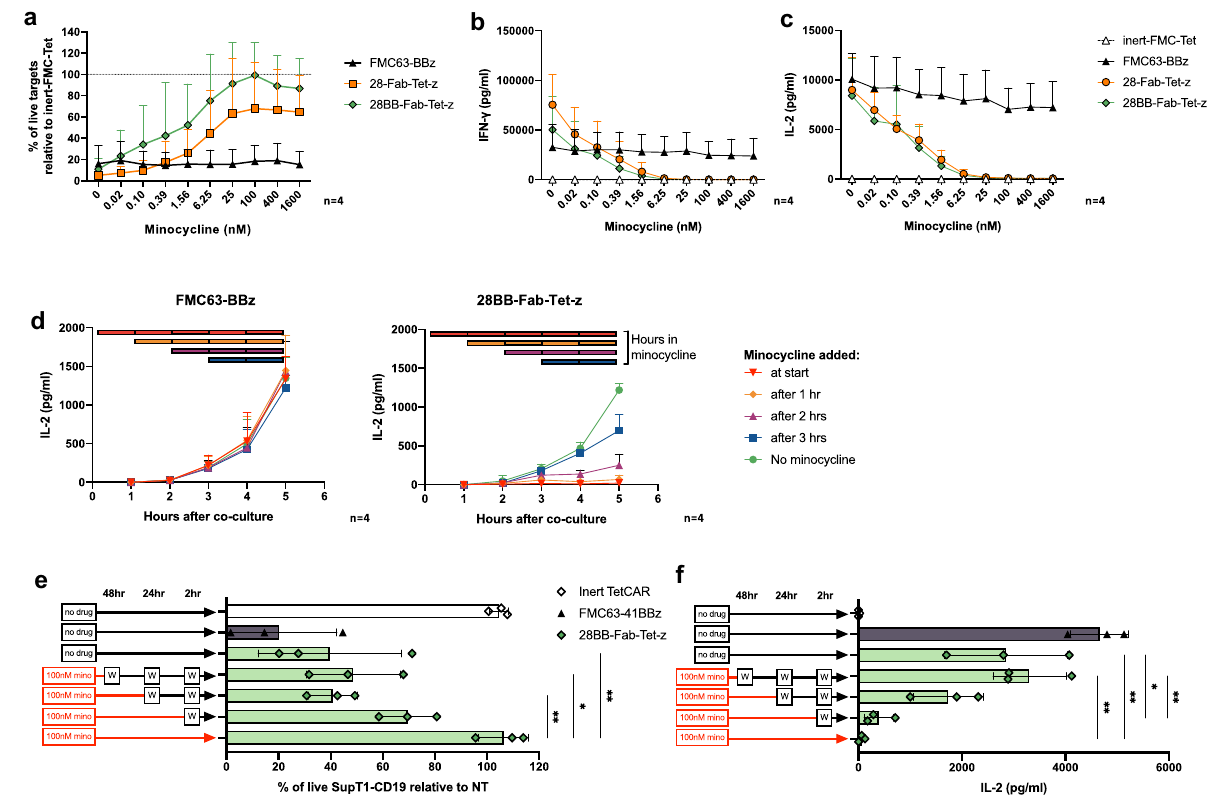
Figure 4. TetCAR activity can be fine-tuned in vitro with a dose-dependent response to minocycline. ( a ) Killing of SupT1-CD19-GFP after 24 h of co-culture with CAR-T cells at 1:4 E:T ratio. A range of minocycline doses from 0.02-1600 nM were added to relevant wells. Data shows mean % of live targets relative to an inert TetCAR control, ± SD. n = 4 donors from 1 experiment. ( b ) IFN-γ and ( c ) IL-2 release after 24 h of co-culture with SupT1-CD19-GFP at various minocycline doses. Data shows mean ± SD, n = 4 donors from 1 experiment. ( d ) IL-2 secretion from FMC63-BBz or 28BB-Fab-Tet-z CARs 1–5 h after co-culture with SupT1-CD19-GFP at a 2:1 E:T ratio. 100 nM minocycline was added to separate wells every hour. Data shows the mean (± SD) secretion of IL-2 at each time-point in groups that received minocycline at the beginning of the experiment, or every hour afterwards. Color coded bars indicate the number of hours that the co-cultures were exposed to minocycline for. n = 4 donors from 2 independent experiments. ( e ) Cytotoxicity or ( f ) IL-2 secretion by 28BB-Fab-Tet-z CARs after coculture with SupT1-CD19 at a 1:1 E:T ratio. Inhibition by minocycline was removed by washing cells with complete media at 48, 24 and 2 h before addition of SupT1-CD19 targets. Wash steps are indicated by “[W]”. Data shows mean (± SD) % of live targets relative to NT T cells ( e ) or mean (± SD) IL-2 secretion ( f ) after 24 h. n = 3 donors from 1 experiment. Statistical analysis was through a one-way ANOVA with multiple comparisons between the 28BB-Fab-Tet-z CAR under different conditions. P values for cytotoxicity ( e ) were: 48 h wash versus no wash (*, 0.0118), 24 h wash versus no wash (**, 0.0050) and no drug versus no wash (**, 0.0044). P values for IL-2 secretion ( f ) were: 48 h wash versus no wash (**, 0.0015), no drug versus no wash (**, 0.0044), no drug versus 2 h wash (*, 0.0103) and 48 h wash versus 2 h wash (**, CD28 co‑stimulation does not increase exhaustion or terminal differentiation in Fab‑TetCAR T cells. Although CD28-CD3ζ endodomains can drive potent CAR T cell activation, this can limit memory formation and skew populations towards short-lived effector cells 22 . To show that Tet-CARs containing a CD28 endodomain were functionally equivalent to control 41BB-CD3ζ monolithic CAR, expression of Lag3/Tim3 or CD62L/CD45RA was evaluated. After the 7-day co-culture with target cells [Fig. 5c,d and Supplementary Fig. S4(a) and (b)], both Lag3 and Tim3 expression on CD3 + T cells were similar in the TetCARs compared with the standard CAR. Likewise, the proportions of the memory populations were similar between the TetCARs and the control CAR. Taken together these data show that even during maximal activation, TetCAR constructs containing CD28 endodomains did not drive an enhanced expression of exhaustion markers or skew differentia- tion of activated T cells. 28BB‑Tet‑CAR can be functionally regulated by minocycline in vivo. Lastly, we evaluated the acti- vation and inhibition of 28BB-Fab-Tet-z CARs in vivo . NSG mice were engrafted with NALM6 engineered to express firefly luciferase (NALM6-Fluc); 4 days later, different cohorts were treated with either 5 × 10 6 NT,